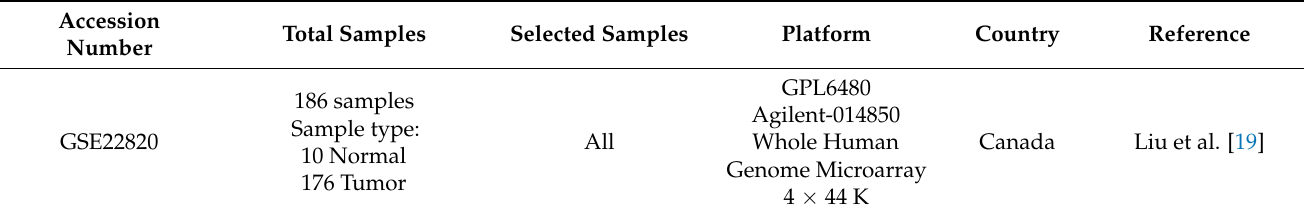
Table 1. Metadata for the microarray and RNASeq